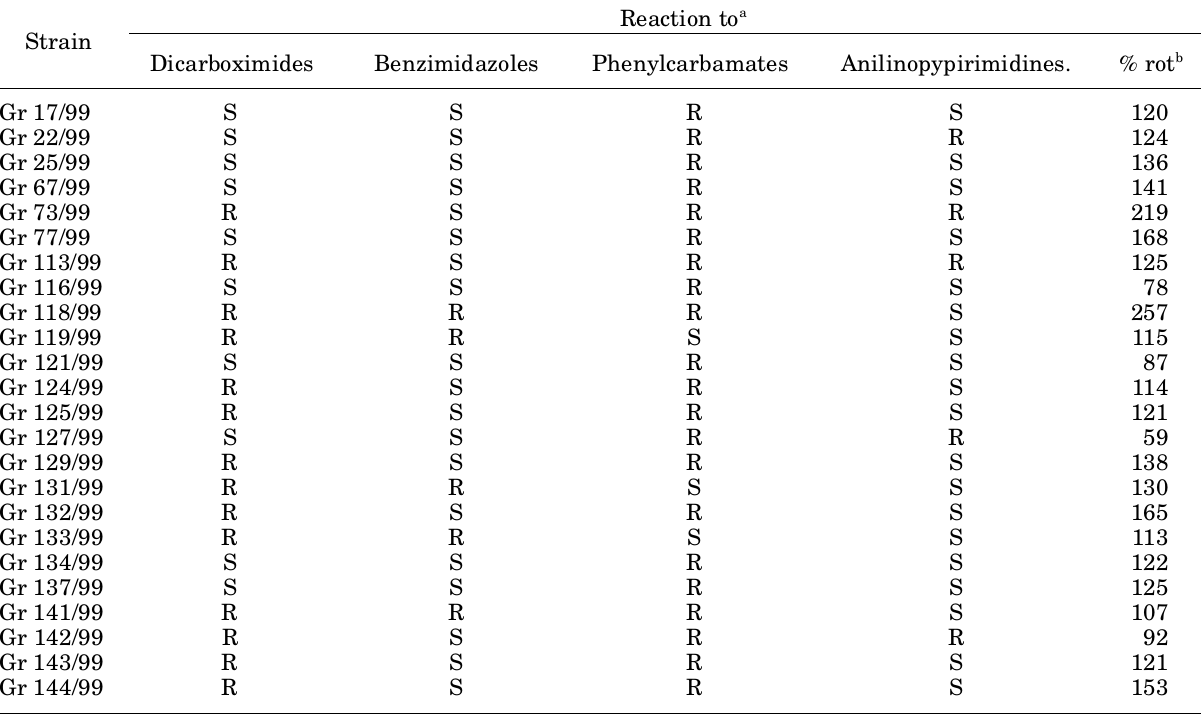
Table 8. Reaction of Botrytis cinerea strains to different classes of botryticides, and virulence of the strains, as evaluated on apple (cv. Golden delicious), tested in